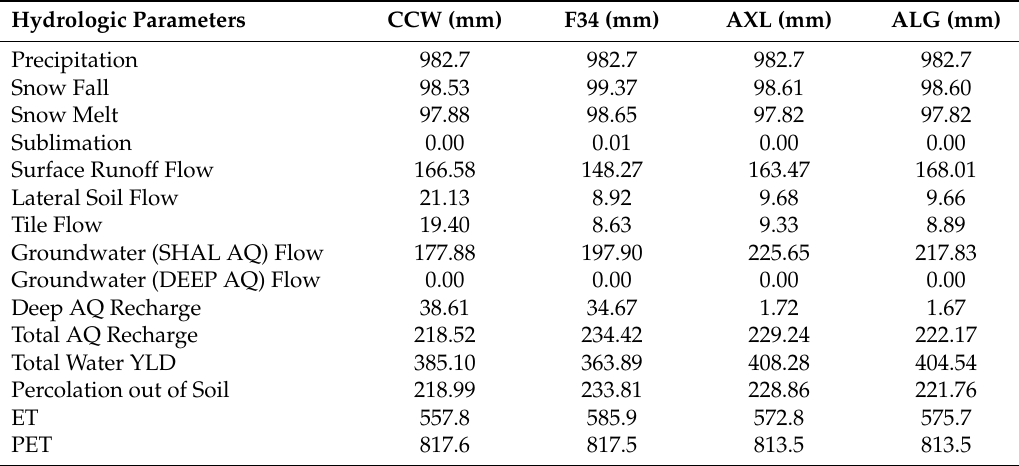
Figure A4. Monthly time series of simulated and observed total P for ( a ) CCW, ( b ) F34, ( c ) AXL, and ( d ) ALG. Table A1. Average annual hydrologic balance for CCW, F34, AXL, and ALG